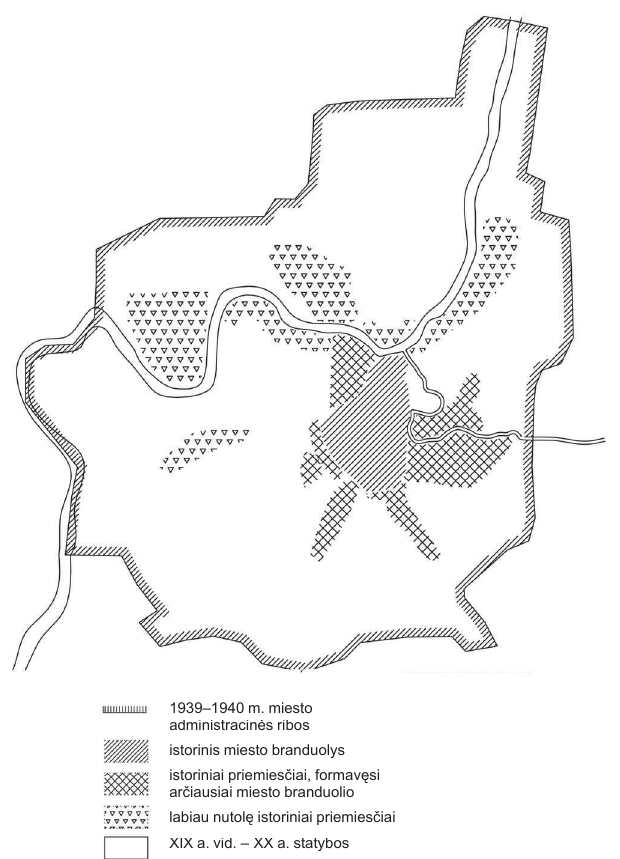
Fig 1. Territory of Vilnius town under study (scheme of administrative borders in